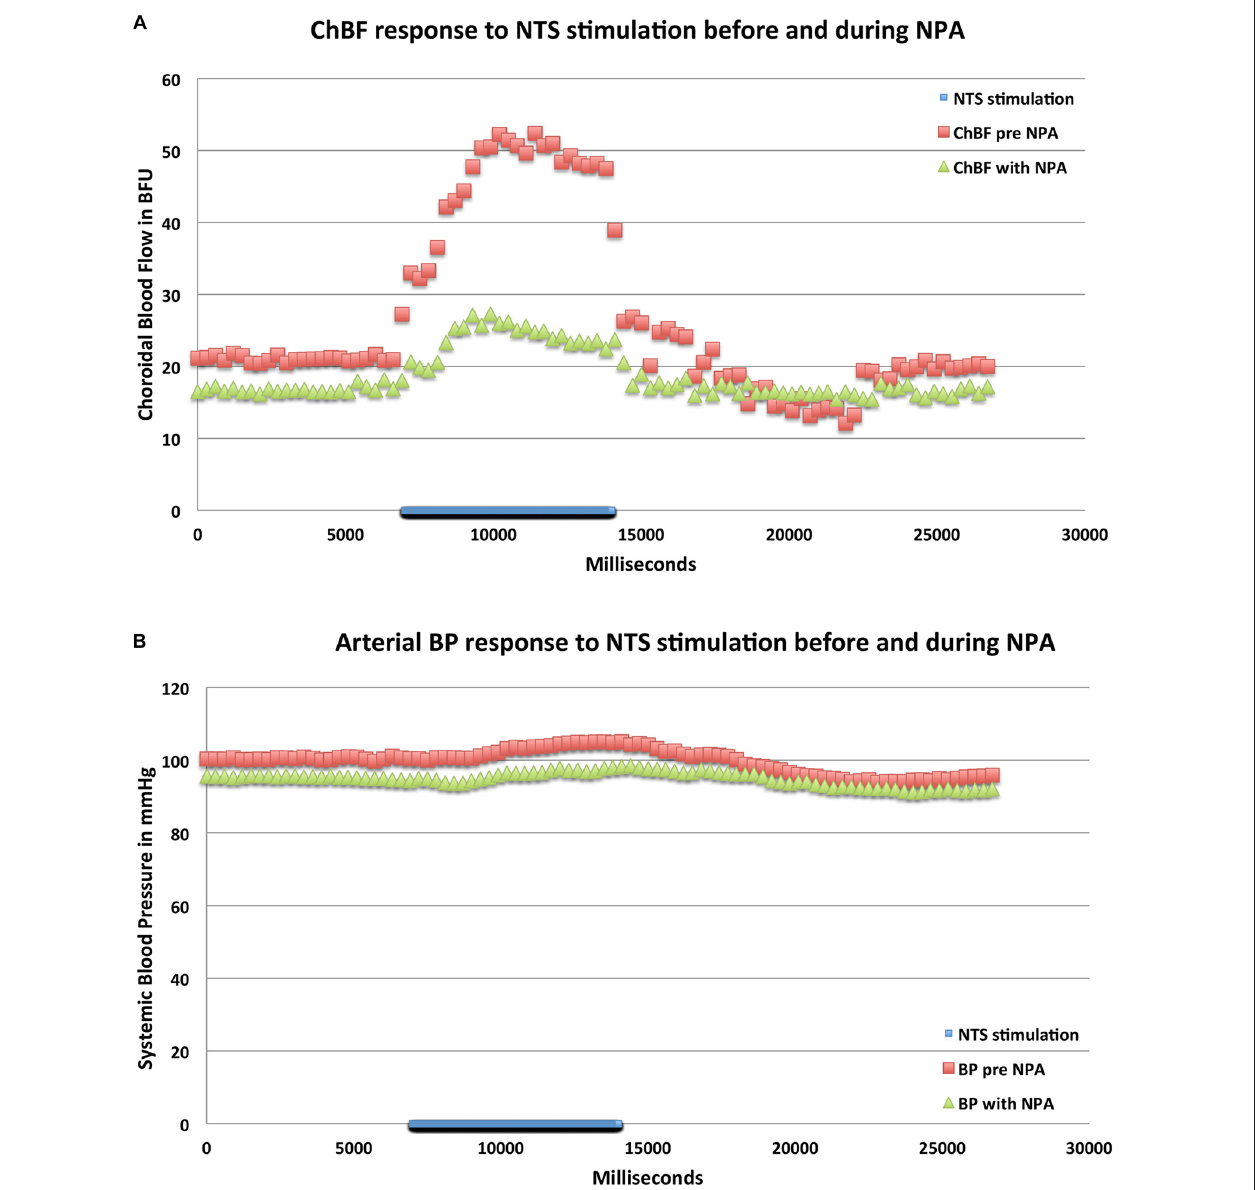
FIGURE 8 | Graphs showing the mean ChBF (A) and ABP (B) responses to stimulation at effective NTS sites prior to and after NPA administration ( n = x ). The blue bar marks the stimulation period. Each data point is the mean for 333 ms. ChBF is expressed in relative blood flow units (BFU) and ABP in mm/Hg. Note that NPA significantly reduces the ChBF response to NTS activation, and has a consistent but insignificant depressive effect on